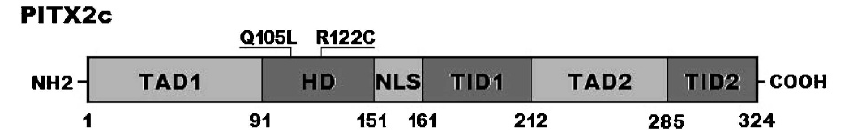
Figure 2 - A schematic representation of the PITX2c protein structure with the atrial fibrillation-related mutations indicated. The mutations identified in patients with atrial fibrillation are shown above the structural domains. NH2 means amino-terminus; TAD1, transcriptional activation domain 1 (amino acids 1–91); HD, homeodomain (amino acids 92–151); NLS, nuclear localization signal (amino acids 145–161); TID1, transcriptional inhibitory domain 1 (amino acids 162–212); TAD2, transcriptional activation domain 2 (amino acids 213–285); TID2, transcriptional inhibitory domain 2 (amino acids 286–324); and COOH,